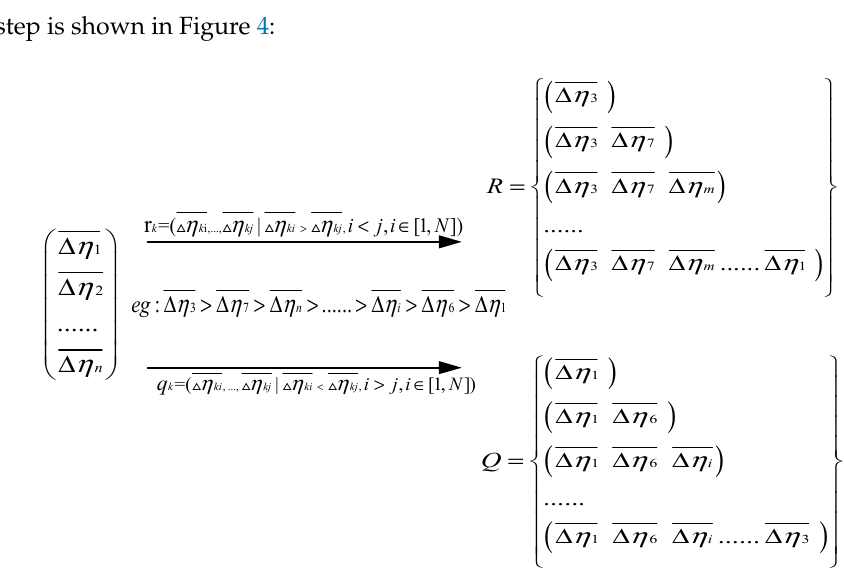
Figure 4. The second step of aMMTS.